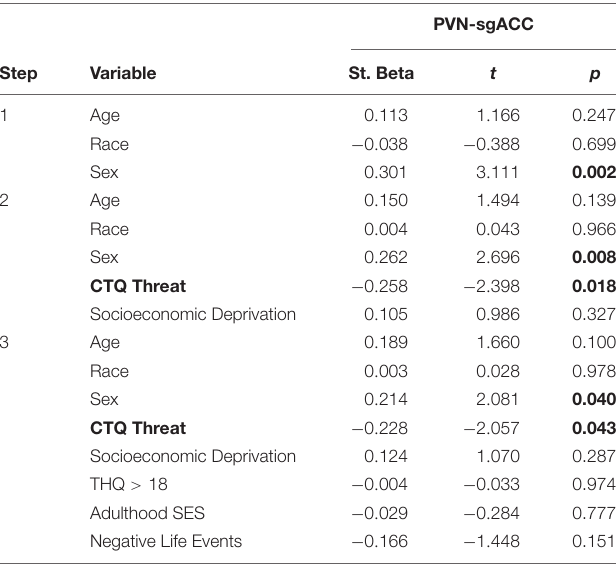
TABLE 3 | Hierarchical linear regression results: childhood threat (abuse) and central visceral network resting-state